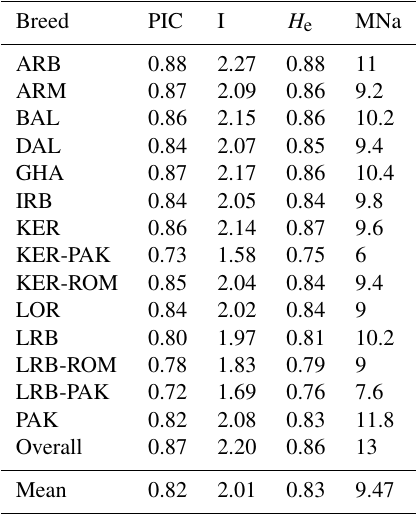
Table 4. Mean polymorphic information content (PIC), mean Shan- non information index (I), mean expected heterozygosity ( H e ) and mean number of actual alleles (MNa) per type across five loci.